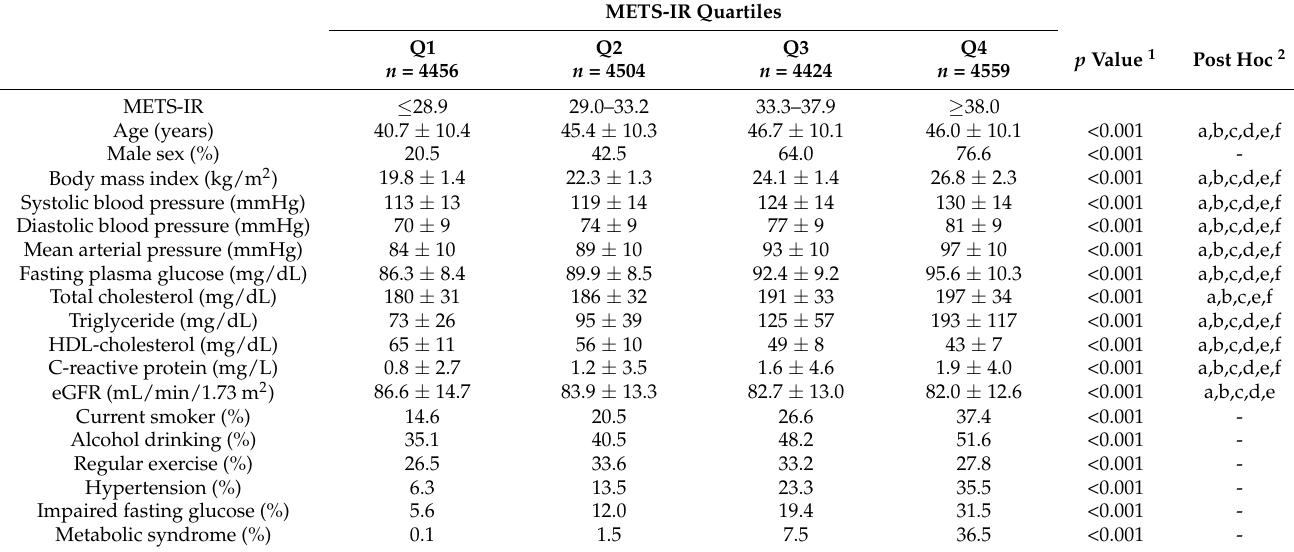
Table 1. Baseline characteristics of the study population according to the METS-IR quartiles.